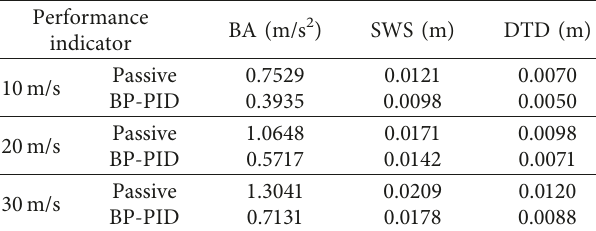
Figure 11: Performance improvement under different roads. Table 4: RMS values of suspension performance indicators at different vehicle speeds.